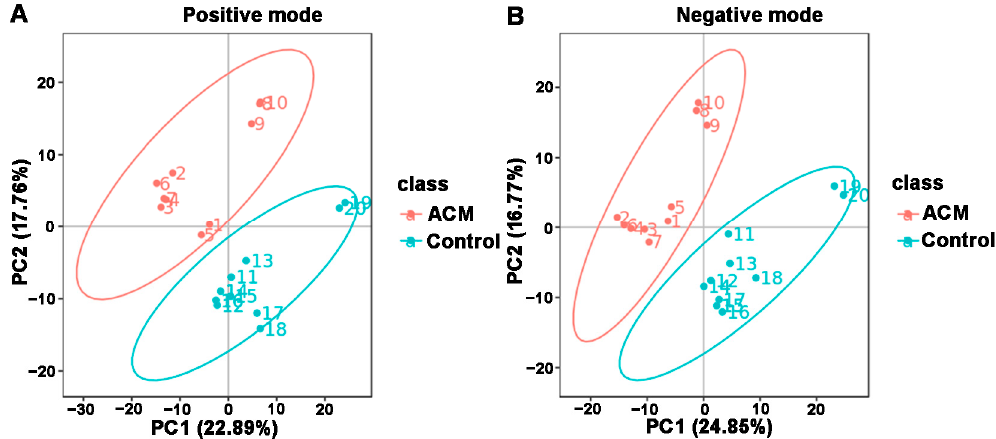
Figure 3. Principal components analysis (PCA) between the control and ACM groups. ( A ) Positive mode; ( B ) negative mode.